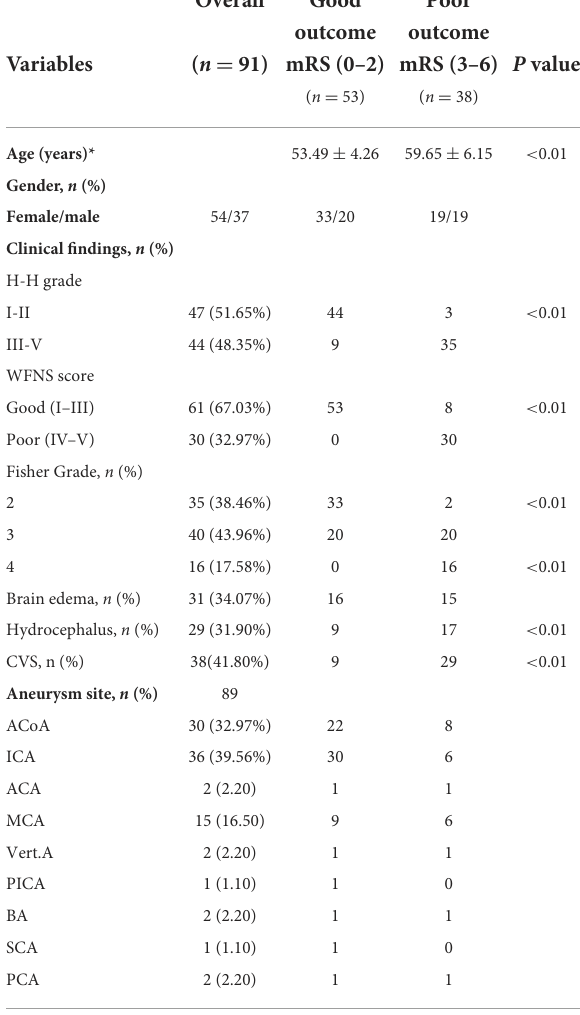
TABLE 1 Baseline demographics and clinical findings of patients with aneurysmal subarachnoid